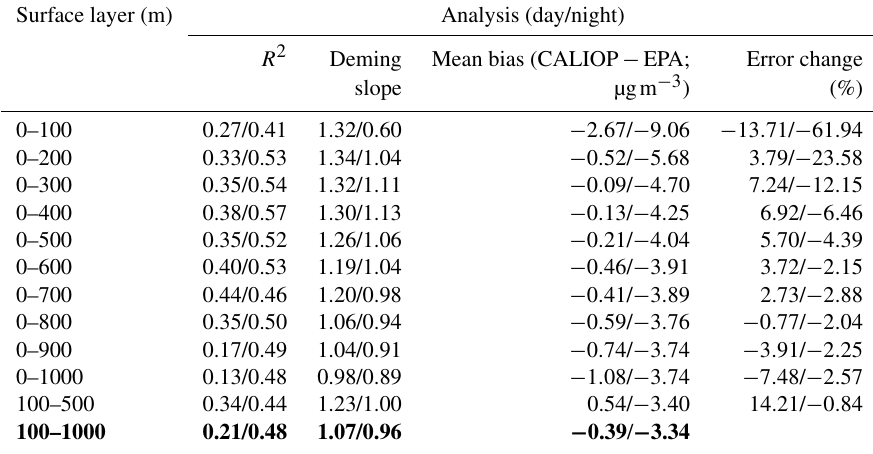
Table 2. Statistical summary of a sensitivity analysis varying the height of the surface layer, including R 2 , slope from Deming re- gression, mean bias (CALIOP − EPA) of PM 2 . 5 in micrograms per cubic meter, and percent error change in derived PM 2 . 5 , defined as (( mean new PM 2 . 5 − mean original PM 2 . 5 )/ mean original PM 2 . 5 ) × 100. The row in bold represents the results shown in the remainder of the